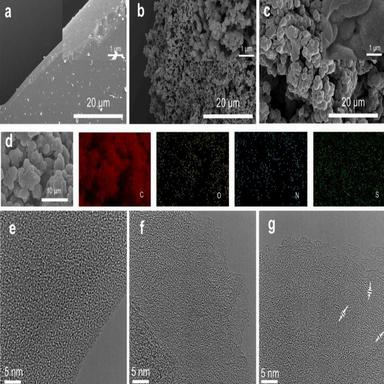
Morphology structure characterization. (a-c) SEM images of D-N/S-800℃, DF-800℃ and DF-N/S-8–2-800℃; (d) the EDS element distribution mapping; (e-f) TEM images of D-N/S-800℃, DF-800℃ and, DF-N/S-8–2-800℃.